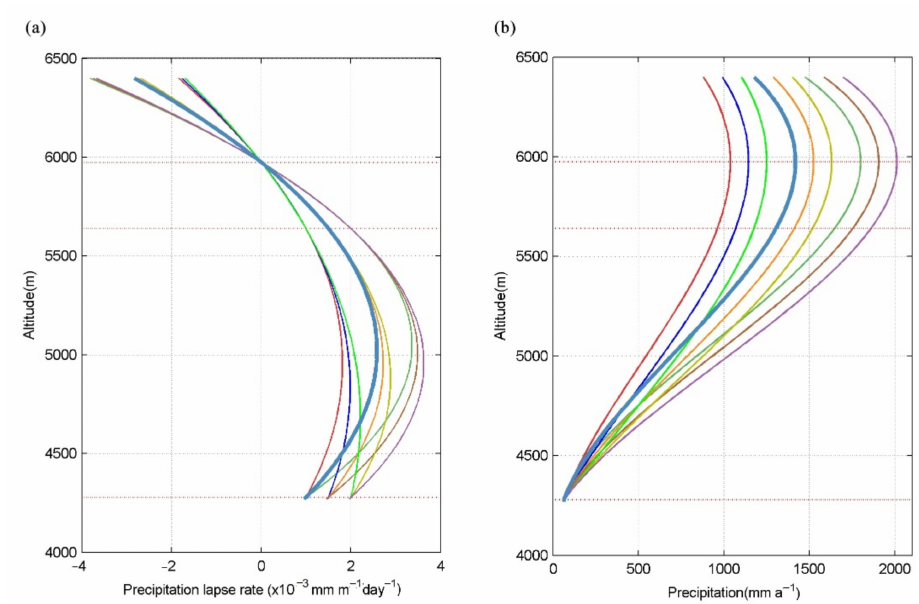
Figure 7. ( a ) The estimated quadratic polynomial profile of elevation − dependent daily precipitation gradients using 9 combinations (by 9 colors) of precipitation gradient values at the Shiquanhe station (4278 m) and AWS (5640 m) from the sets {0.1, 0.15, 0.2} mm (100 m day) − 1 and zero value at 5975 m; for instance, the thick light blue curve represents the best fit combination that using the precipitation gradient of 0.1 mm (100 m day) − 1 at 4278 m and 0.15 mm (100 m day) − 1 at 5640 m and 0 at 5975 m; ( b ) the estimated total precipitation using the estimated precipitation gradients in plot ( a ) and daily precipitation records at the Shiquanhe station from August 2015 to August 2016. The three elevations of 4278 m, 5640 m, and 5975 m are marked by red dotted